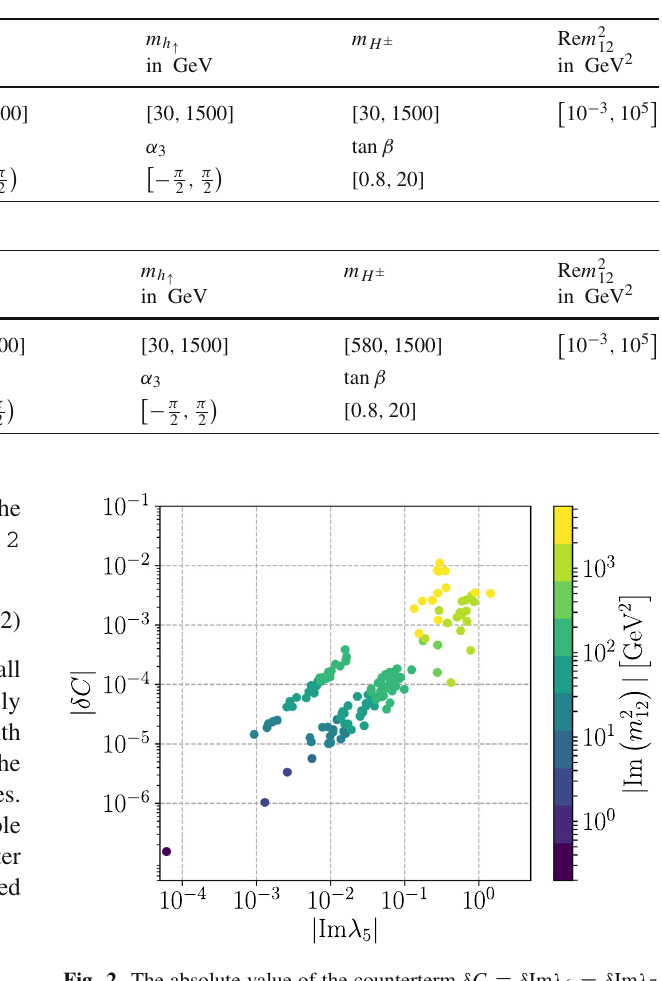
Fig. 2 The absolute value of the counterterm δ C ≡ δ Im λ 6 = δ Im λ 7 for all points passing our constraints with ξ c ≥ 1 as function of | Im λ 5 |